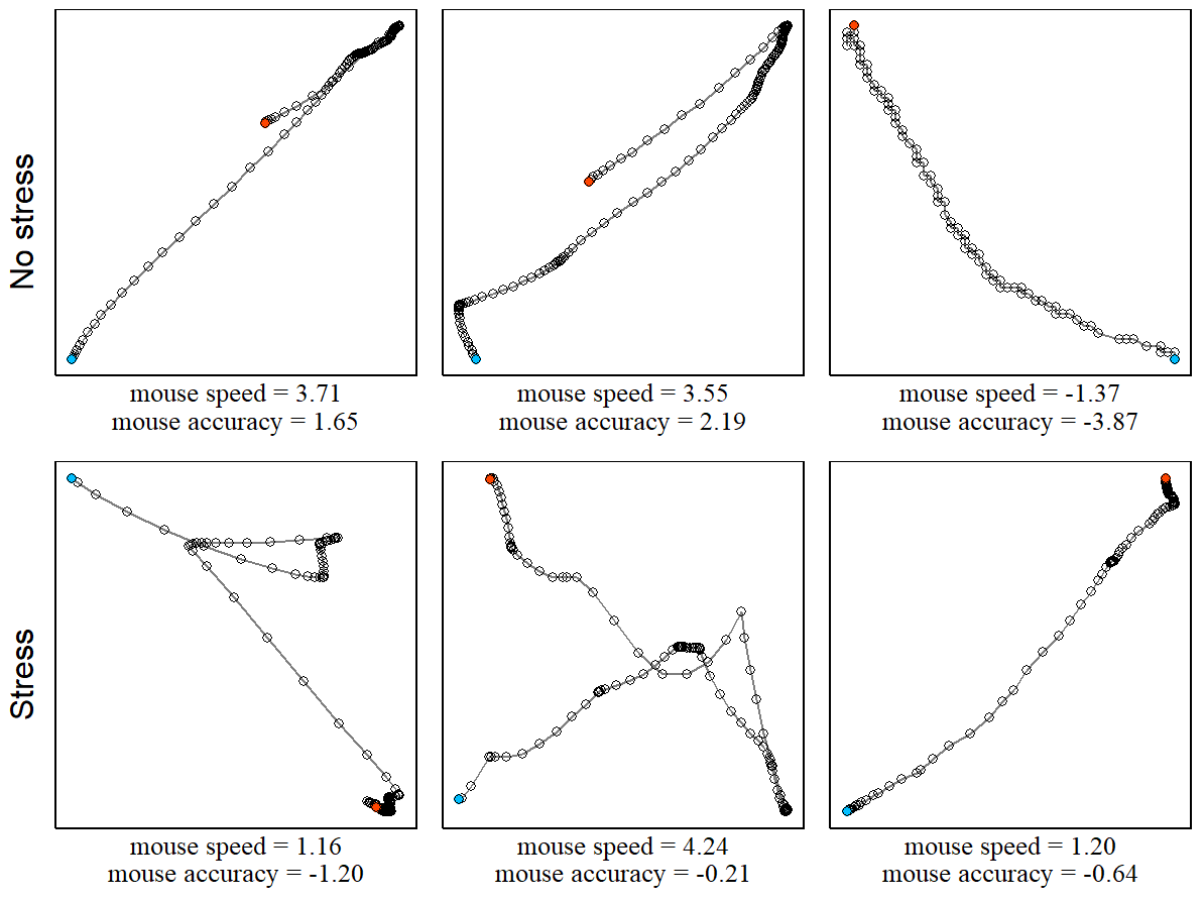
Figure 2. Illustrative examples of the speed-accuracy trade-off in computer mouse movements. Shown are typical computer mouse movements (blue dot: beginning of movement; red dot: click) from the field study. Circles correspond to recordings at 125 Hz. When subjects perceived no stress, computer mouse movements were typically not characterized by a speed-accuracy trade-off. When subjects perceived stress, computer mouse movements were typically characterized by a speed-accuracy trade-off. Mouse speed and accuracy were standardized to indicate the direction of the trade-off; that is, high speed (+) and low accuracy (−) or low speed (−) and high accuracy